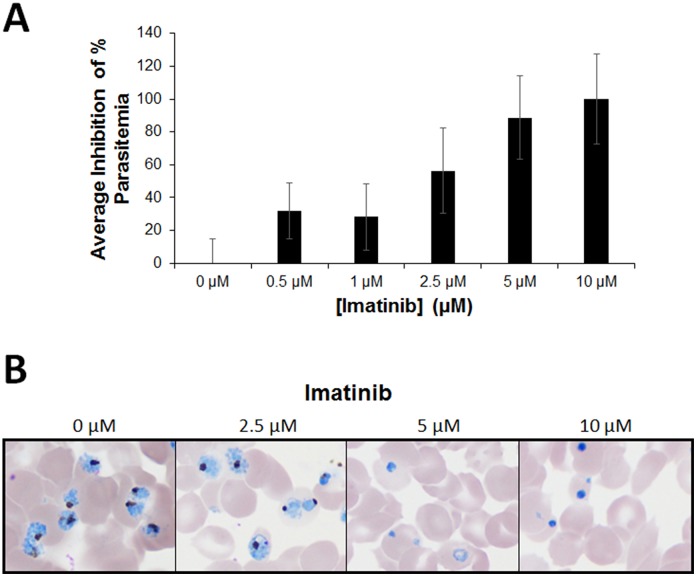
Ex vivo drug susceptibility of fresh P. falciparum clinical isolates in Uganda to imatinib treatment.Fresh blood samples from malaria patients were obtained with written informed consent and analyzed for their sensitivities to imatinib as described in Methods. (A) The parasitemia of each sample was determined as a function of imatinib concentration by qPCR analysis of extracted parasite DNA. Percent inhibition of parasitemia is plotted as a function of imatinib concentration. (B) Parasite morphology was assessed by microscopic evaluation of thin blood smears stained with fresh 10% Giemsa. Light micrographs of cultures were acquired using a Nikon Elipse CI-L microscope, Plan Fluor 100X oil objective, Numerical Aperture 1.3 at room temperature equipped with a Nikon DS-Fi2 digital camera and NIS-Elements Basic Research acquisition software. Representative images at the indicated imatinib concentrations are shown.